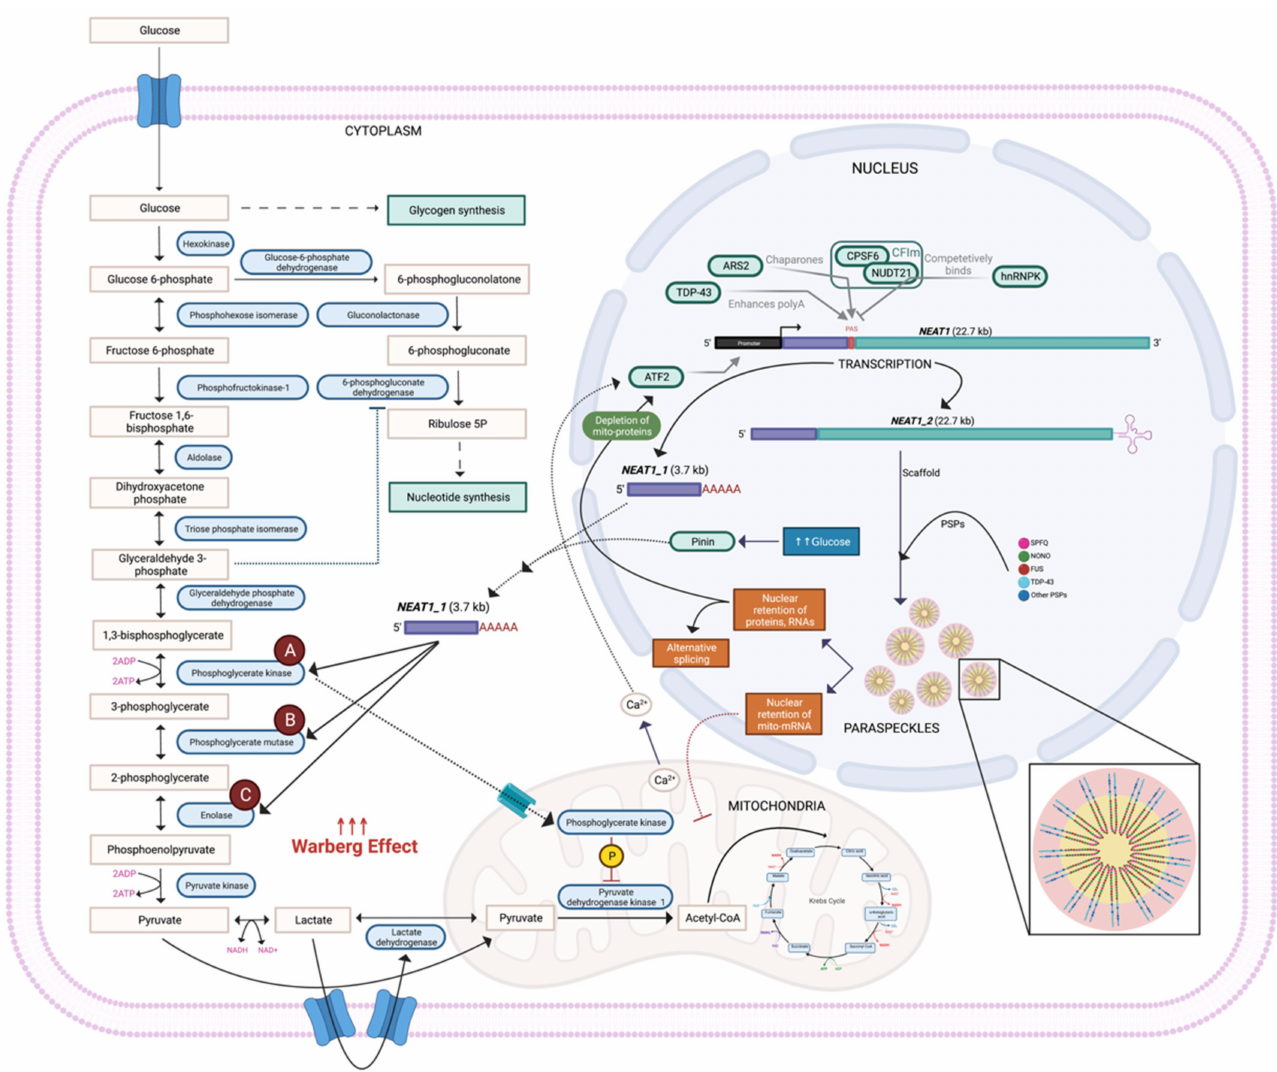
Figure 2. Nucleocytoplasmic transport of NEAT1_1 enhances the Warburg effect via the binding to glycolytic enzymes. TDP-43, ARS2, and CFIm promote the canonical 3 (cid:48) polyadenylation of NEAT1_1, which can then bind to pinin for nuclear export to the cytoplasm. Once in the cytoplasm, NEAT1_1 can bind with the glycolytic enzymes PGK1 ( A ), PGAM1 ( B ), and ENO1 ( C ) to enhance glycolytic flux, and hence the Warberg effect, in transformed